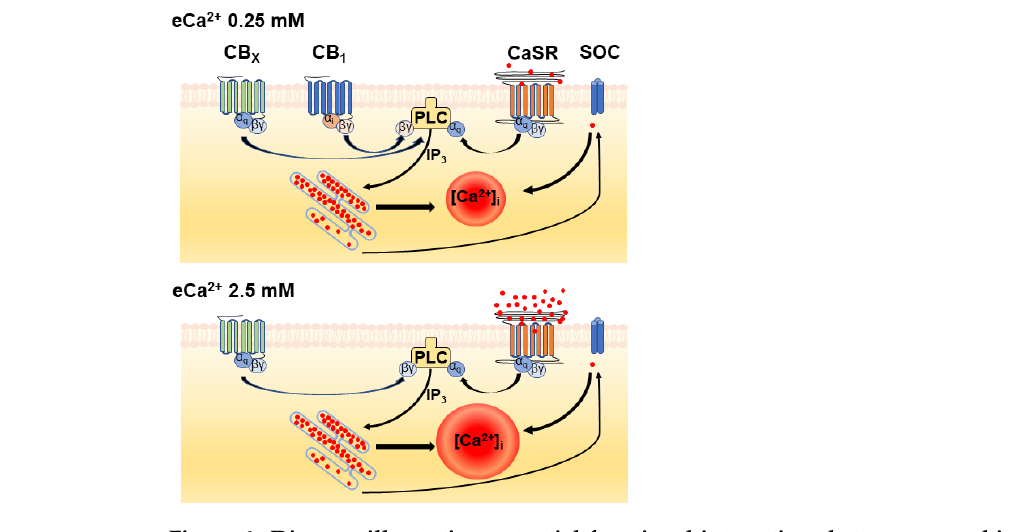
Figure 6. Diagram illustrating potential functional interactions between cannabinoid receptors and CaSR in neuroblastoma cells in different levels of eCa 2+ . The formation of different G α q -PLC- G i/o βγ complexes depending on eCa 2+ and cellular proximity of the GPCRs involved is proposed. CB 1 : CB 1 receptor. CBx: putative ‘WIN55212-2’ receptor. CaSR: calcium sensing receptor. SOC: store operated calcium channels.